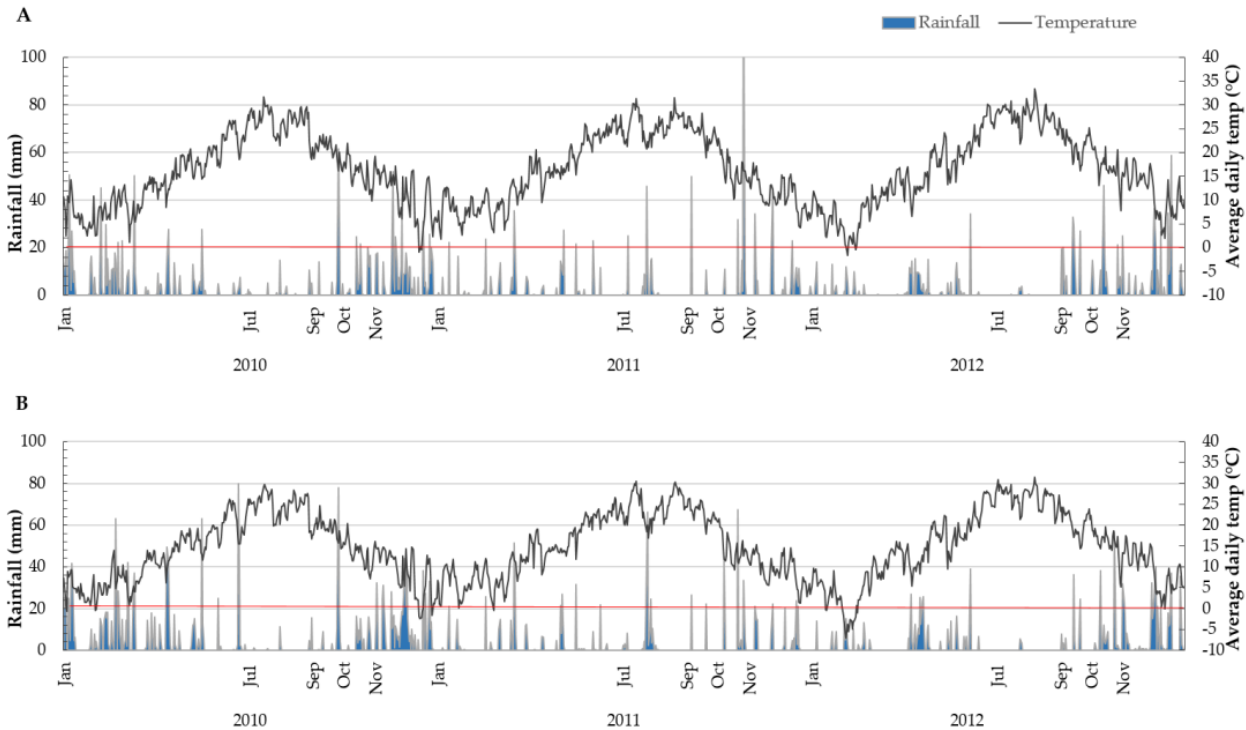
Figure 1. Microclimatic parameters measured for each olive growing site; ( A ) Kaštela and ( B ) Šestanovac. The year 2010 was recorded as the highest rainfall year (1397.9 mm, 1961.9 mm; Kaštela and Šestanovac respectively) and the year with the lowest average daily air temperatures. Comparing the overall 3 years of research for the period July–November, higher mean daily temperatures were recorded in 2012 (except September, the highest temperatures were measured in 2011 at both